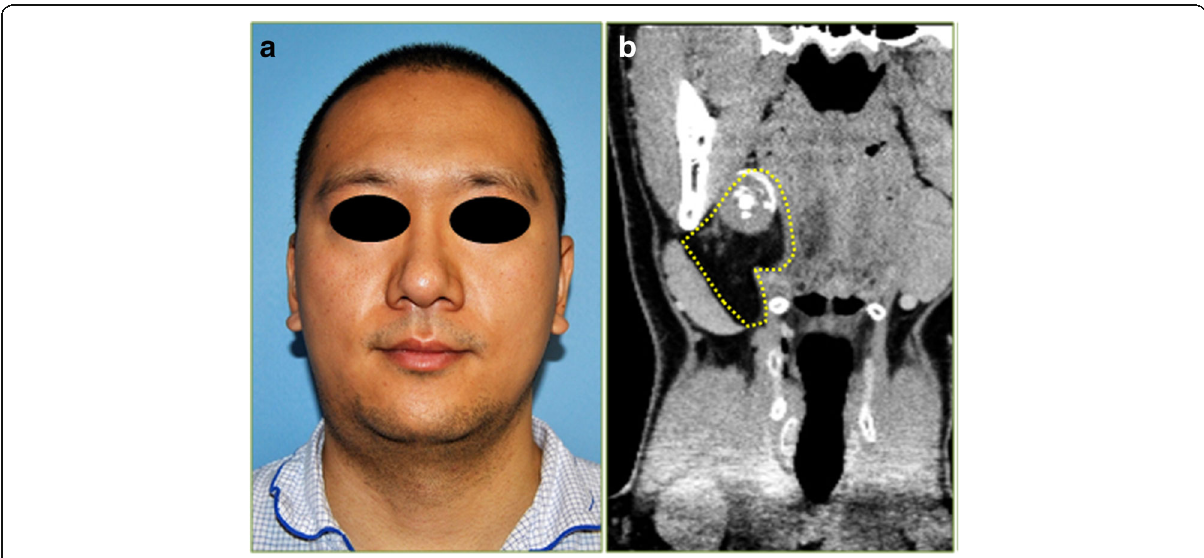
Fig. 1 Extraoral photograph shows a mass in the patient ’ s right submandibular region ( a ). Coronal head CT scan shows a mixed lesion (outlined by the dotted line) near the right submandibular gland ( b